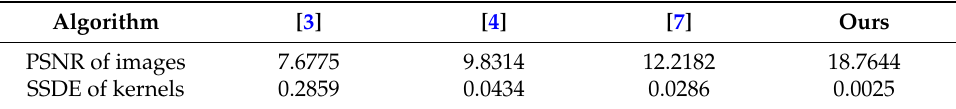
Table 1. Comparison of the results in Figure